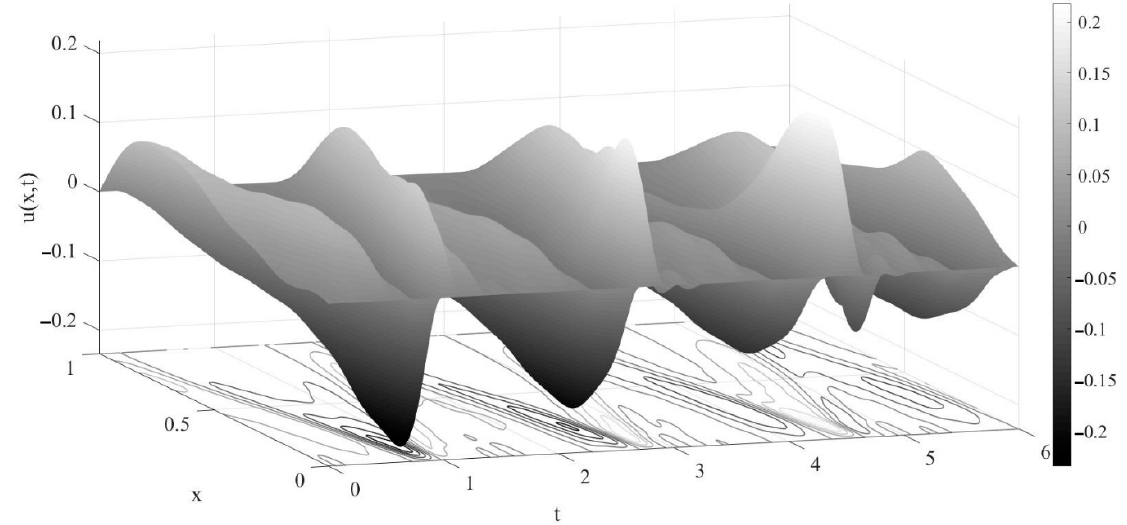
Figure 5. A graph of the approximate solution u ( 7 ) ( x , t ) of problems (1)–(4) under the imposed conditions in Example 4.